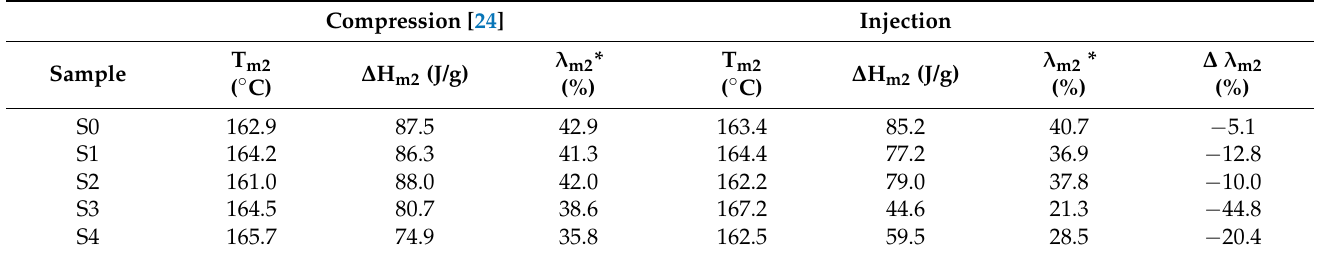
Table 4. Thermal parameters from DSC second heating